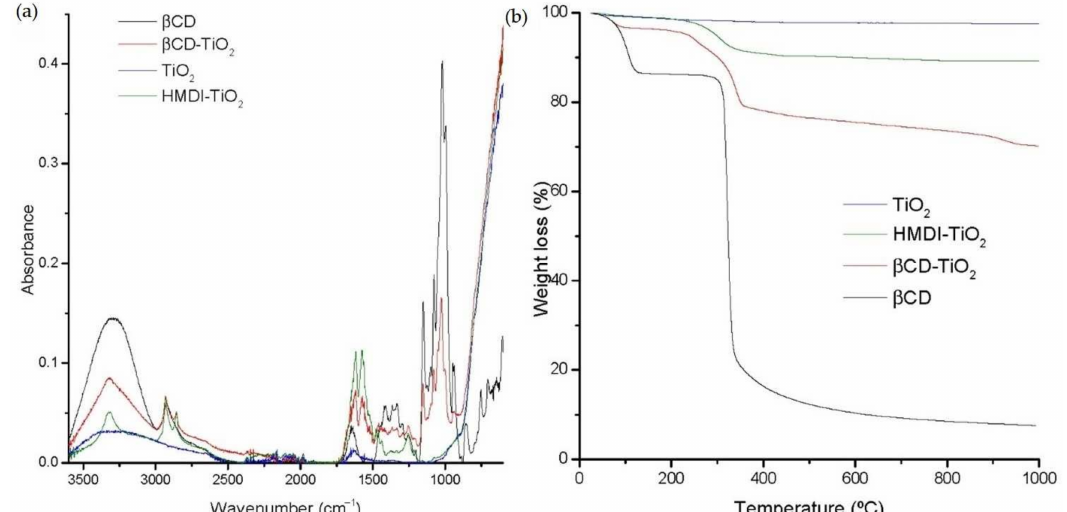
Figure 1. ( a ) FTIR spectra of TiO 2 , HMDI-TiO 2 , β CD and β CD-TiO 2 NPs. ( b ) TGA curves of TiO 2 , HMDI-TiO 2 , β CD and β CD-TiO 2